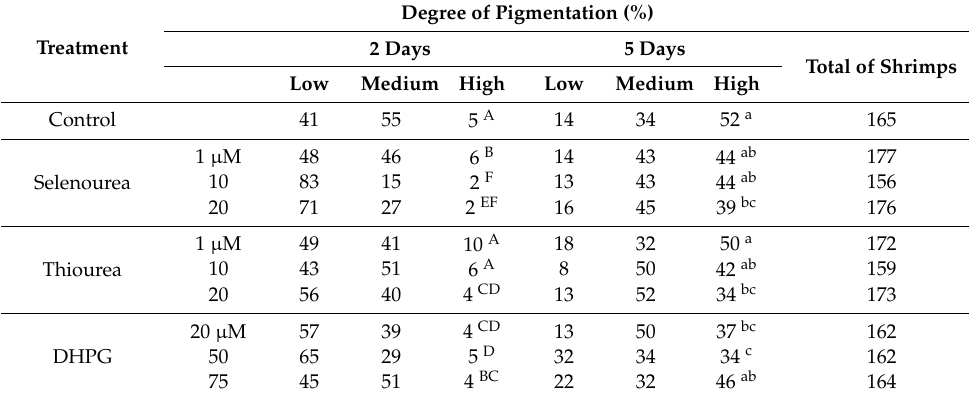
Table 3. Melanosis score evaluated as degree of pigmentation (low, medium, and high) during refrigerated storage at 4–6 ◦ C of shrimps treated for 10 min with different concentrations of selenourea, thiourea, and 3,4-Dihydroxyphenylglycol (DHPG) a . Degree of Pigmentation (%) Treatment 2